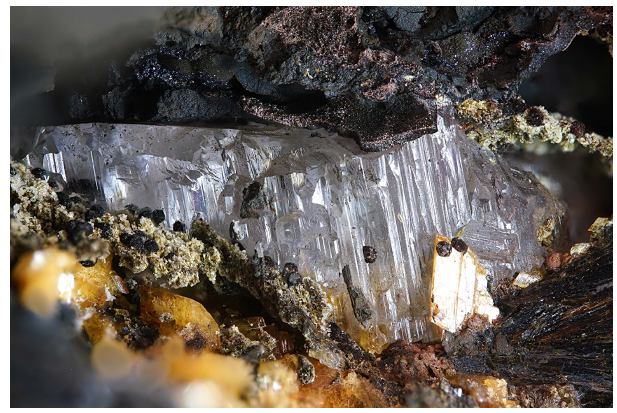
Figure 4. Colourless 2mm wide crystal mass of transparent nizamoffite from Hagendorf Süd, associated with black Mn oxides and yellow laueite crystals. Photo by Christian